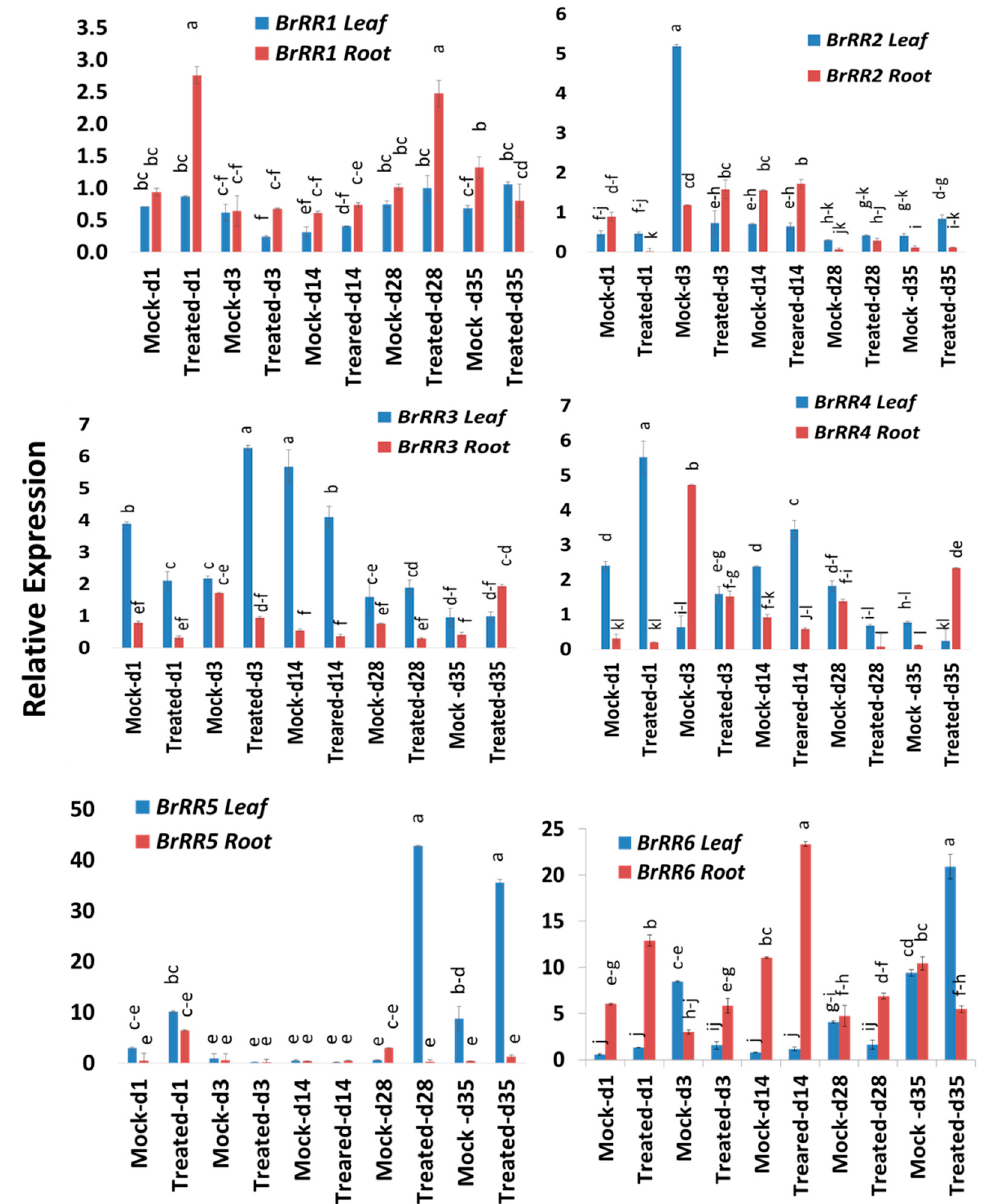
Figure 4. Variation in relative expression levels of BrRR cytokinin-related genes in leaf and root samples under different treatment × time-point combinations. Vertical bars compare relative expression levels among leaf vs. root, mock vs. treated samples at five time-points. Each data point represents the average of three samples. Vertical bars represent standard deviation. Values with different letters are significantly different at 5% level of significance according to Tukey’s pairwise comparisons. Gene expression levels in leaves from non-treated plants on Day 0 were set to 1.